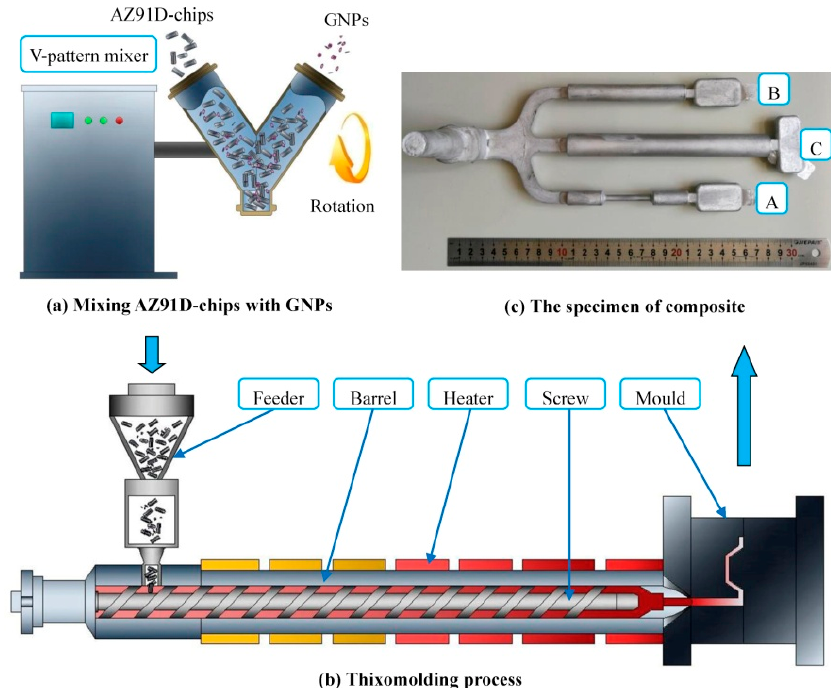
Figure 17. The schematic diagram for the preparation of GNPs–AZ91D magnesium alloy [186] (Copyright Elsevier, 2019, Journal of Alloys and Compounds).